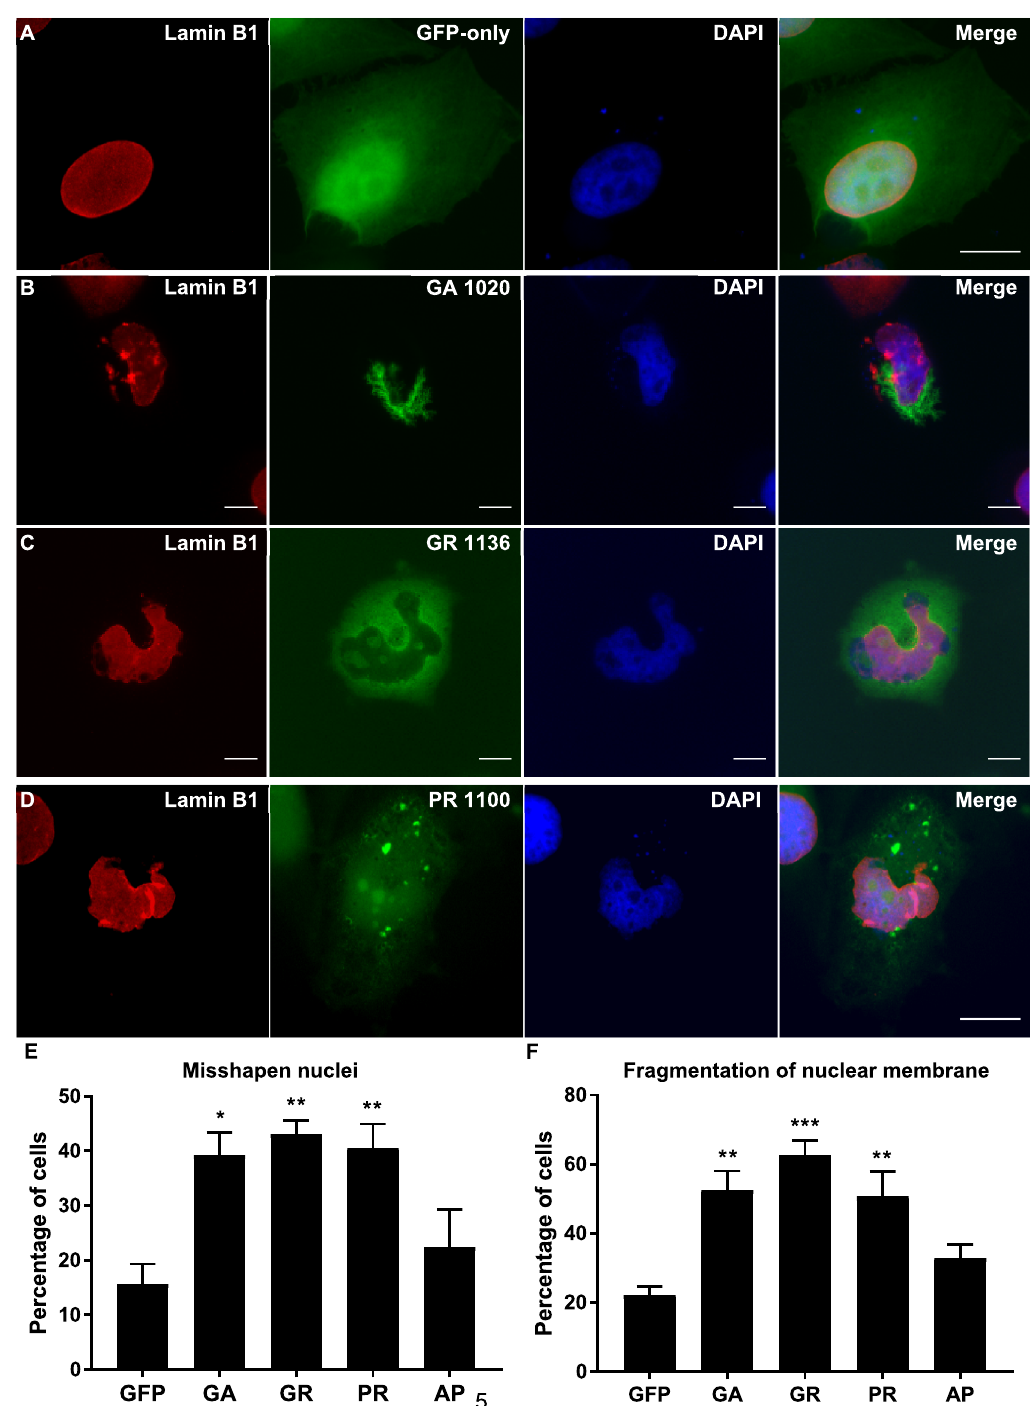
Figure 1. Abnormal nuclei in DPR-expressing cells. ( A – D ) Lamin B1 was used as a marker for the nuclear membrane (red). HeLa cells transfected with GFP-tagged DPR constructs or empty pEGFP-N1 vector as a GFP-only control were fixed and stained 48 h post-transfection. Nuclei were frequently “horseshoe-shaped” or excessively folded in cells containing GA 1020 ( P = 0.0131), GR 1136 ( P = 0.0052) or PR 1100 inclusions ( P = 0.0096). AP 1024 did not cause nuclear abnormalities (data not shown; P = 0.6797). In addition, the nuclear membrane is fragmented in cells expressing GA 1020 ( P = 0.0047), GR 1136 ( P = 0.0006) or PR 1100 ( P = 0.0071), but not AP 1024 (data not shown; P = 0. 3865). DAPI was used to stain nuclei (blue). Scale bars indicate 15 μm. ( E , F ) Graphs shows percentage of transfected cells with misshapen nuclei ( E ) or fragmented nuclear membranes ( F ). n = 3, with a minimum of 30 cells analysed for each independent replicate. Data was analysed by one-way ANOVA with Dunnett’s multiple comparison test. Error bars indicate